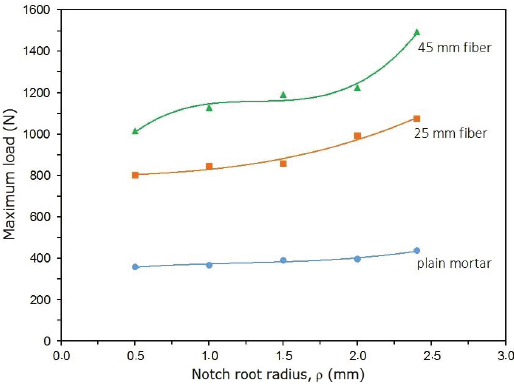
Figure 7. Influence of the notch root radius on the maximum load for the different mortars.